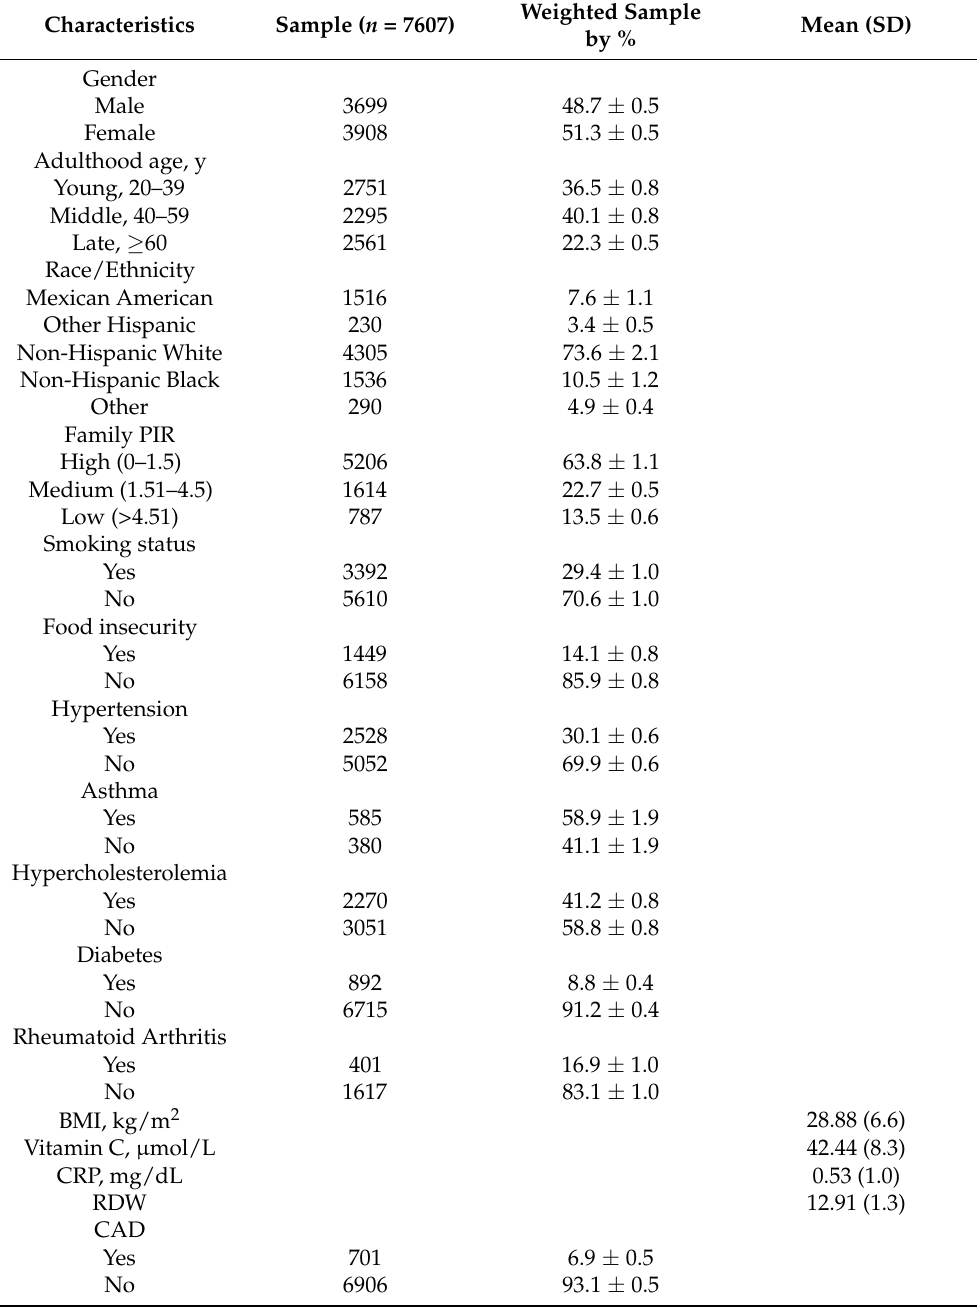
Table 1. Sample Description ( n = 7607) in NHANES 2003–2006